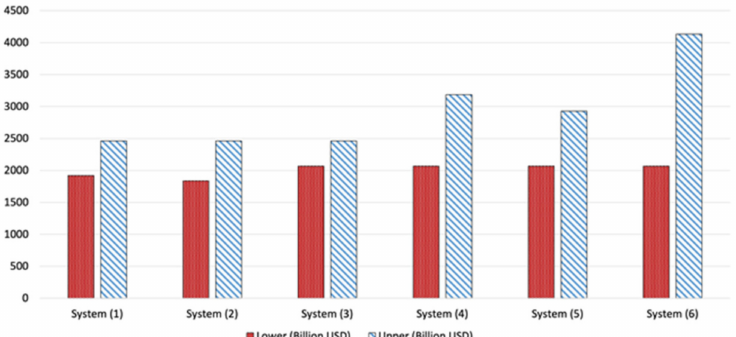
Figure 12. Total investment cost in the residential building sector in Saudi Arabia by government intervention through renewable